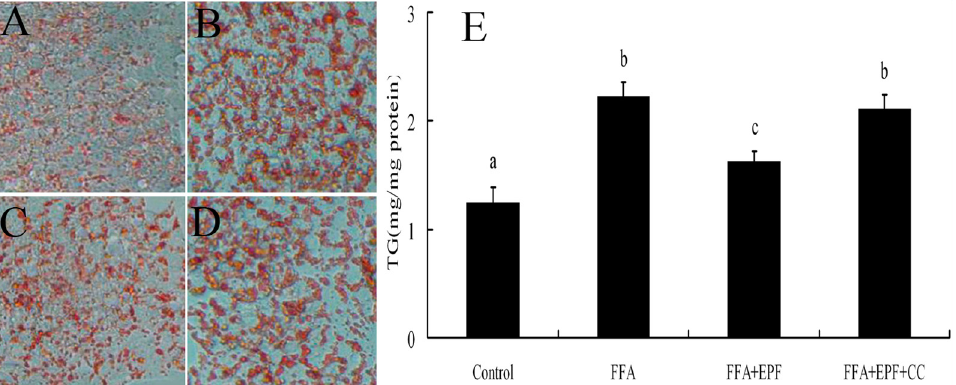
Figure 4. AMPK inhibition reduces the effect of EPF on lipid accumulation in FFA (free fatty acids) exposed hepatocytes: ( A ) control cells; ( B ) FFA treated cells; ( C ) FFA + EPF treated cells; ( D ) FFA + EPF + Compound C treated cells; amd ( E ) the level of intracellular TG in HepG2 cells. The cells were treated with 1 mM FFA mixture for 24 h and EPF (100 μ g/mL) was treated 1 h prior to FFA mixture exposure. The cells were stained with Oil Red O and analyzed using a spectrometer at 545 nm.